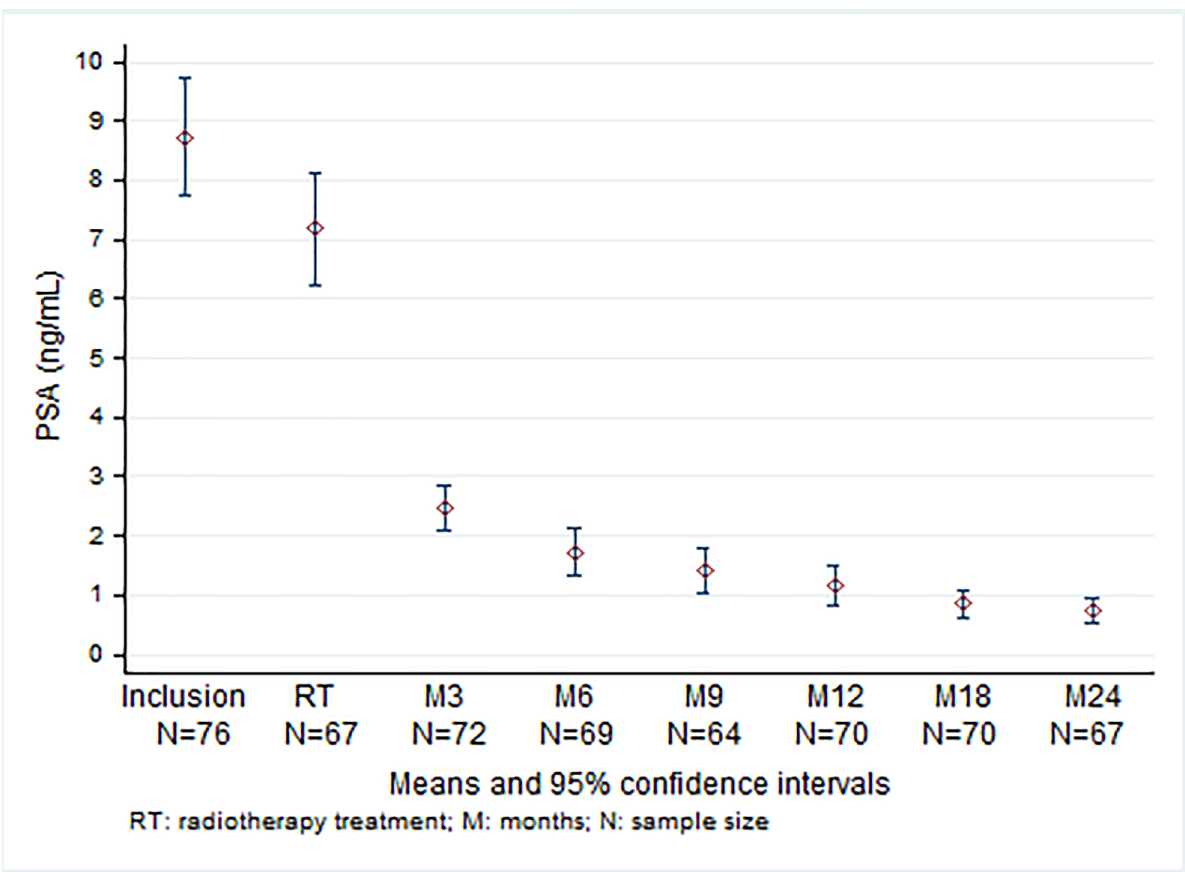
Fig 3. PSA at baseline, during radiotherapy treatment and during follow-up.